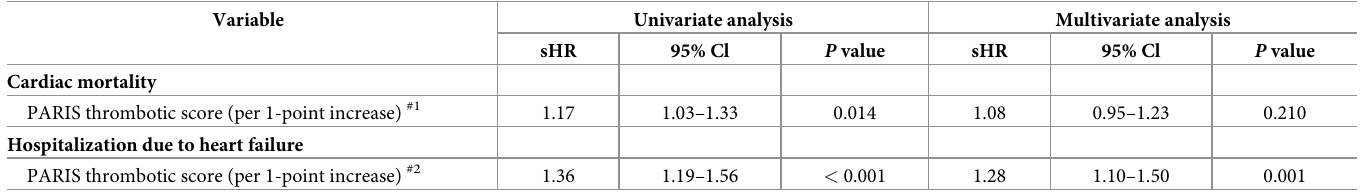
Table 8. Fine and Gray model (subdistribution hazard model) of PARIS thrombotic score (continuous variables) for cardiac mortality and hospitalization due to heart failure.